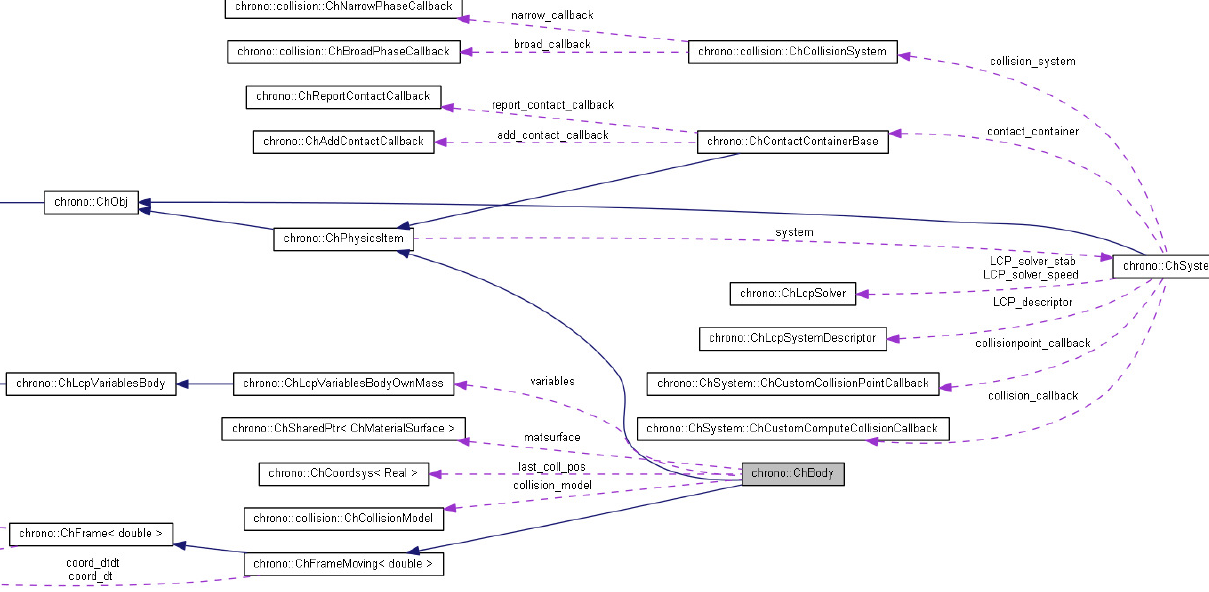
Figure 4 : Network of asset workflows.